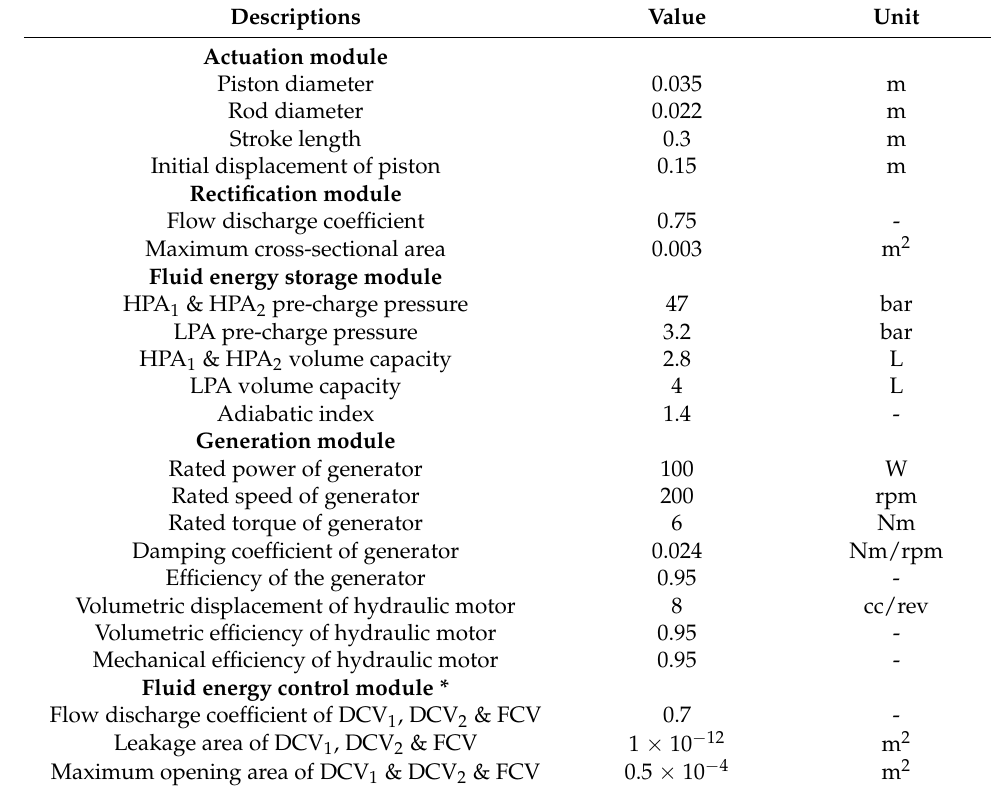
Table 2. HPTO models